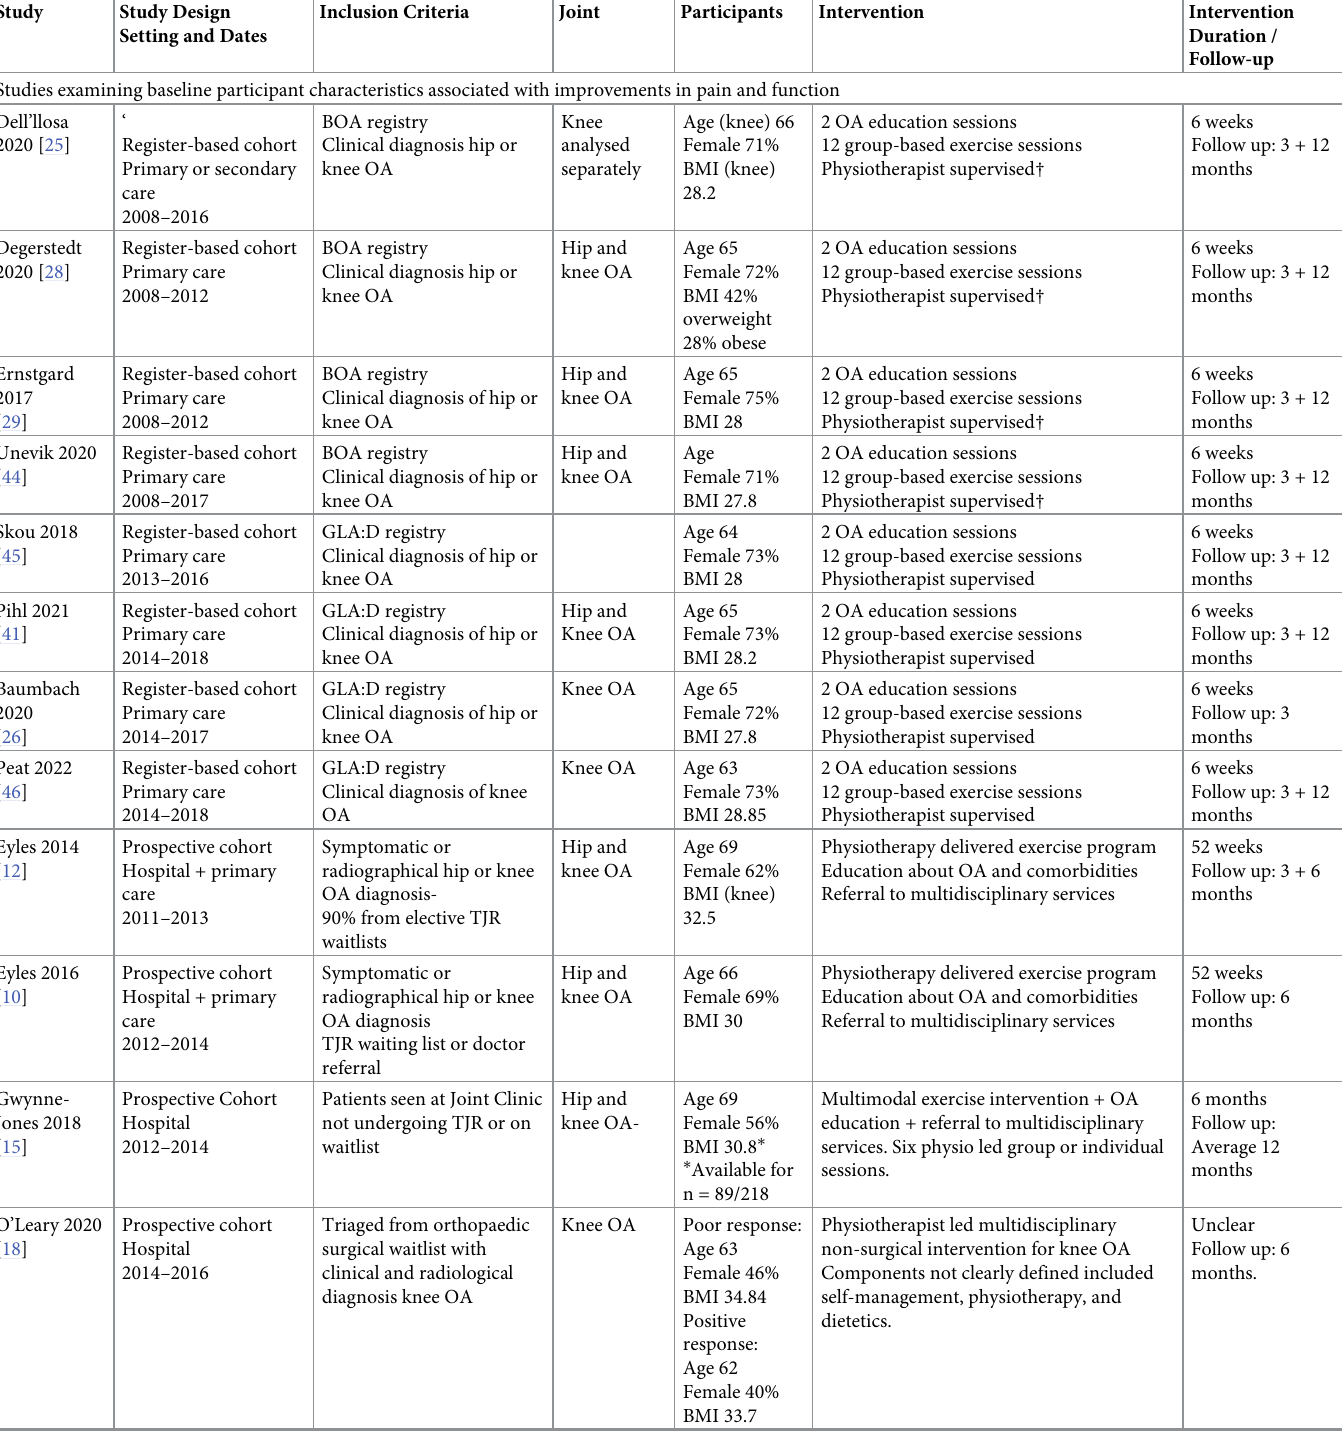
Table 1. Study characteristics (study design, inclusion criteria and intervention